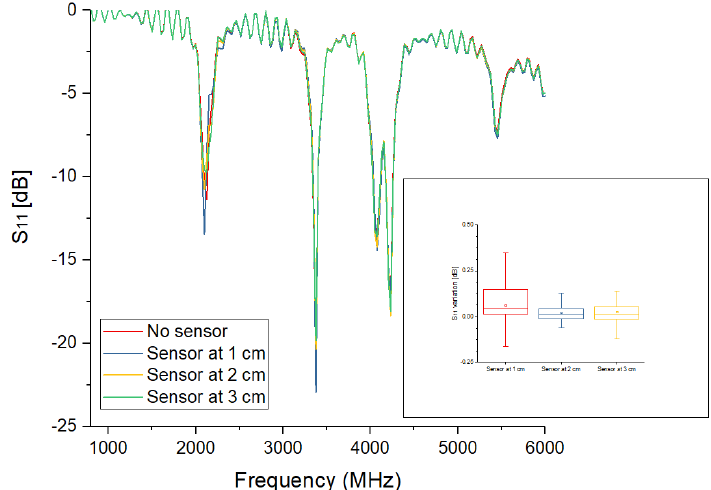
Figure 10. Patch antenna S 11 parameter variation with frequency in different experimental scenarios.